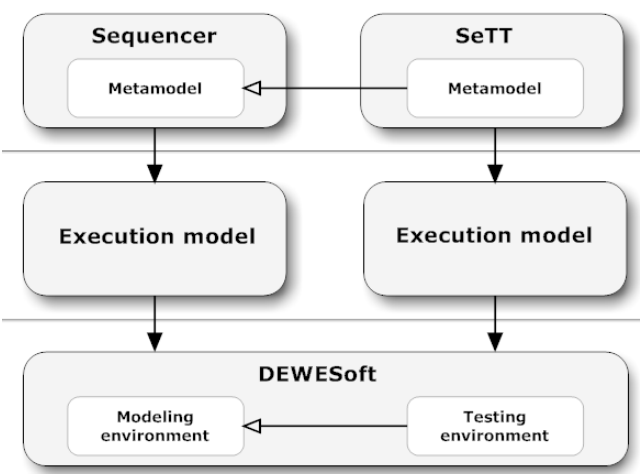
Figure 4. Relation between Sequencer and SeTT in